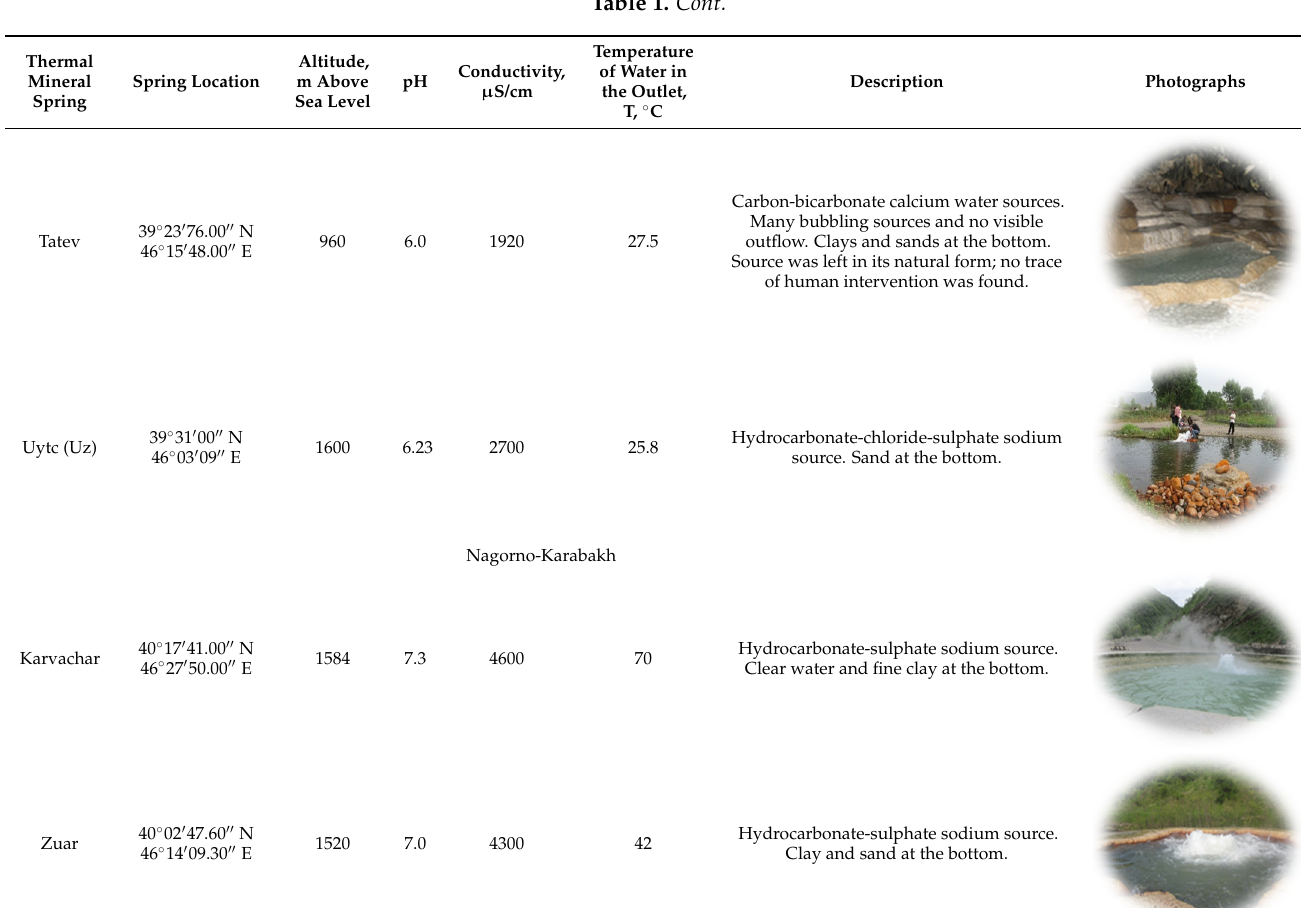
sodium source. Clay and sand at the